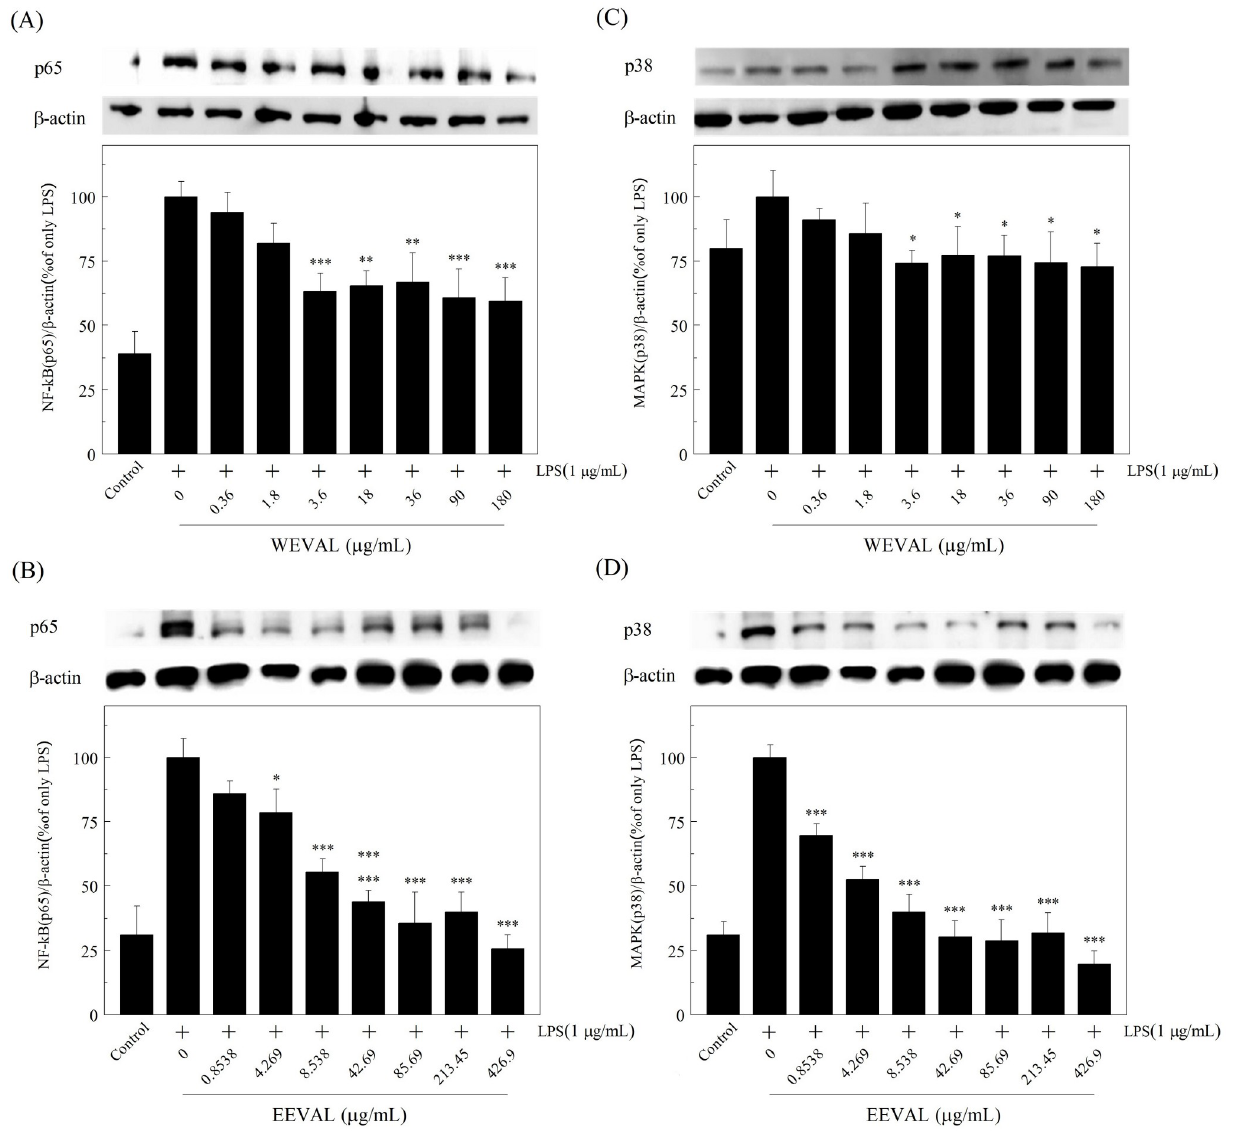
Fig 4. The effects of VA extracts on p65 and p38 protein expression in LPS-stimulated RAW 264.7 macrophages. The effects of (A) WEVAL and (B) EEVAL on p65 protein expression and the effects of (C) WEVAL and (D)EEVAL on p38 protein expression. Results are expressed as mean ± SD of triplicate experiments. Statistically significant changes were clustered as significant ( � ) where p < 0.05, more significant ( �� ) where p < 0.01 and highly significant ( ��� ) where p < 0.001 as compared with LPS-stimulated group.